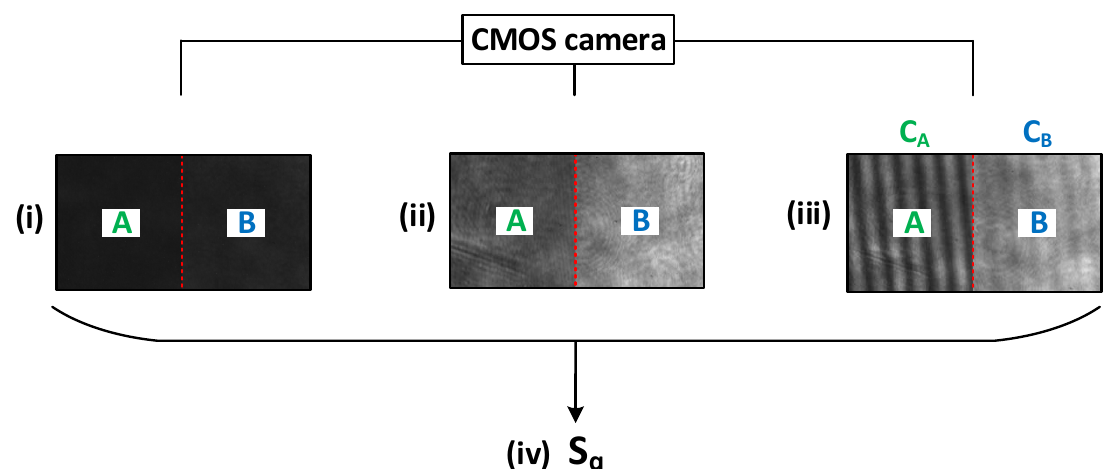
Figure 2. Measurement procedure and data evaluation. A : part A without the QWP, B : part B